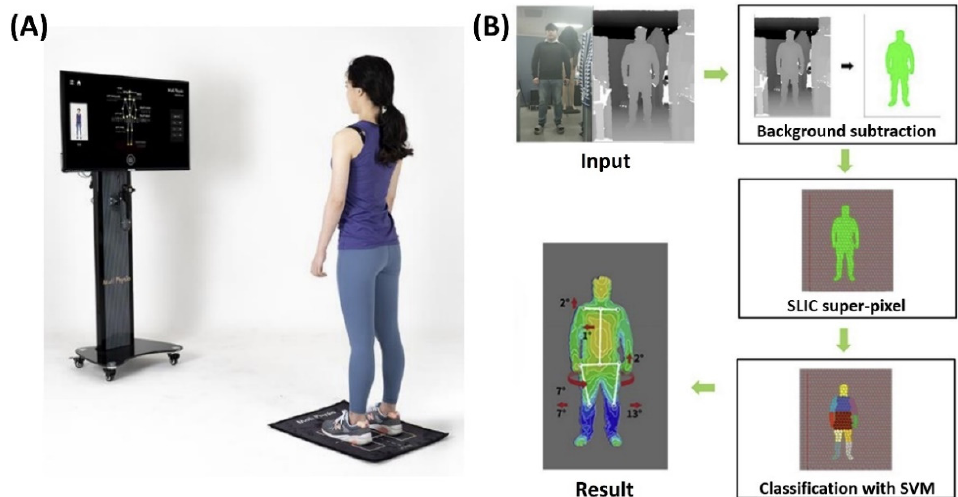
Figure 1. ( A ) Posture analyzing and virtual reconstruction device (PAViR) system. ( B ) The process of reconstructing human posture measurements using PAViR. SLIC, simple linear iterative clustering; SVM, support vector machine.